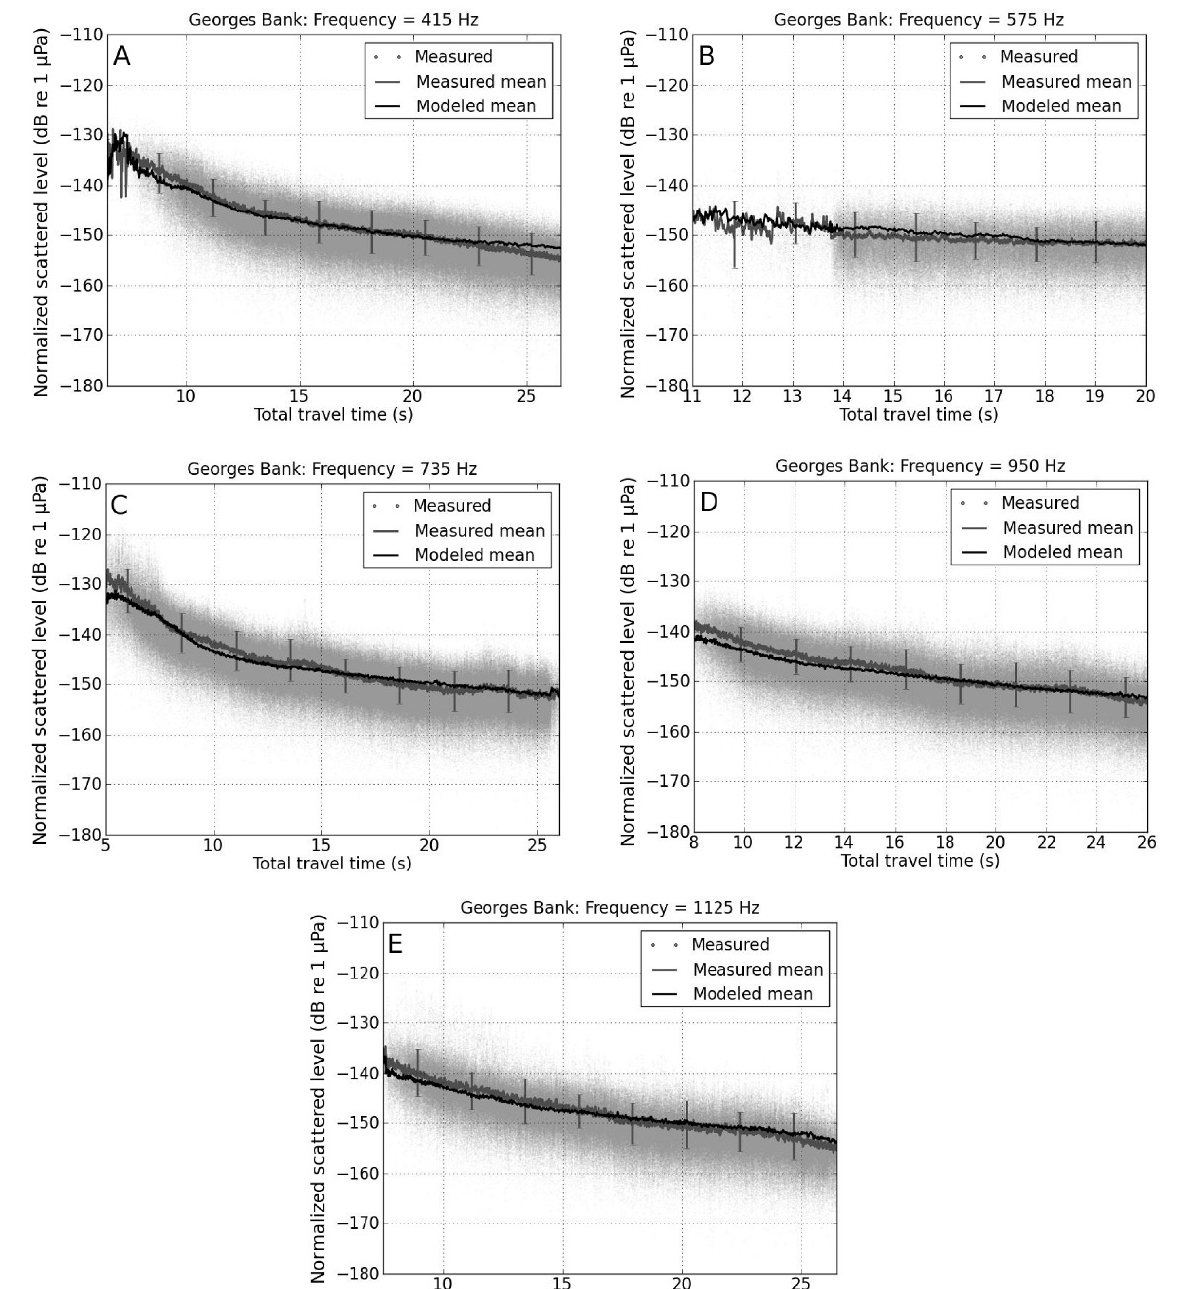
Figure A.3. Comparison between the measured normalized seafloor scattering and the modeled normalized seafloor scattering in the Georges Bank at ( A ) 415 Hz using 410 radial beams, ( B ) 575 Hz using 458 radial beams, ( C ) 735 Hz using 405 radial beams, ( D ) 950 Hz using 408 radial beams and ( E ) 1,125 Hz using 312 radial beams as a function of the total travel time (Section 3.1). The darker regions in the measured scattered level indicate a higher density of data points. The standard deviation of the measured level (vertical tick marks) is calculated from all the data points that fall within the travel time corresponding to an OAWRS range resolution [9] seconds around a given travel time. The total travel time is the two-way travel time from the source to the seafloor and from the seafloor to the